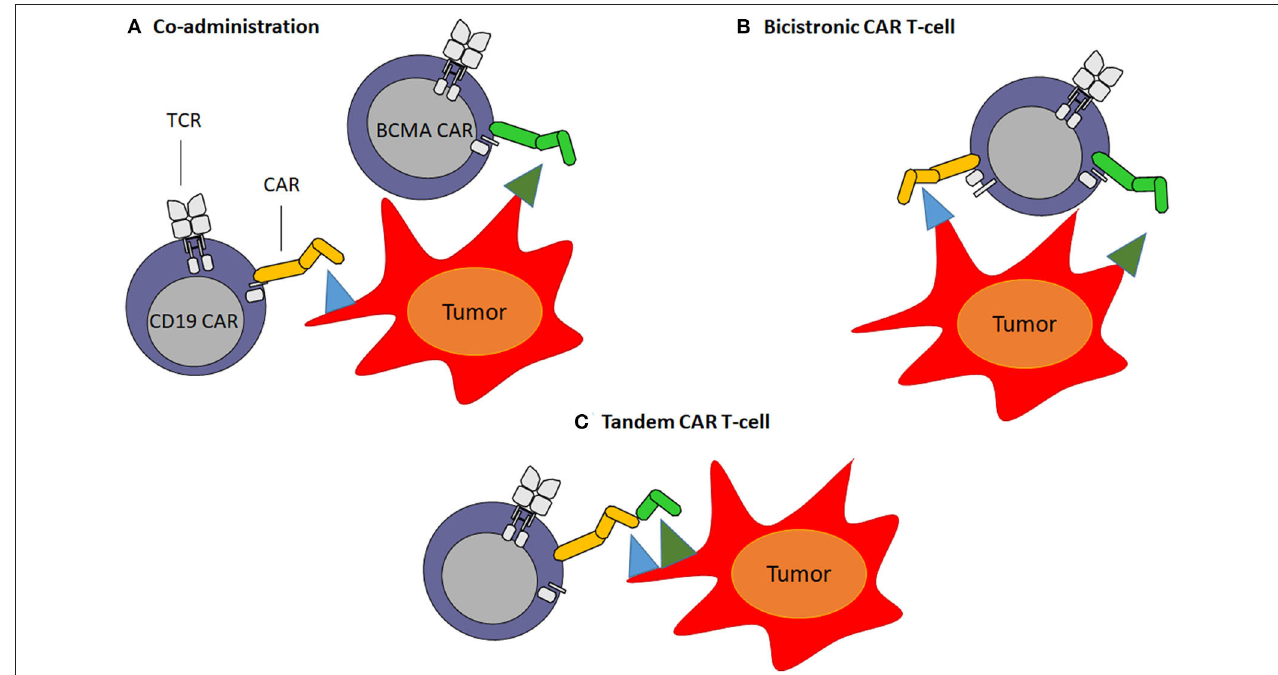
FIGURE 2 | Multi-targeted CAR T-cell approaches. (A) Co-administration: involves production of two separate CAR T-cell products infused together or sequentially. (B) Bicistronic CAR T-cells: consist of the expression of two different CARs on the same T-cell. (C) Tandem CAR T-cells: consist of encoding two different scFv antibodies on same chimeric antigen receptor protein using a single